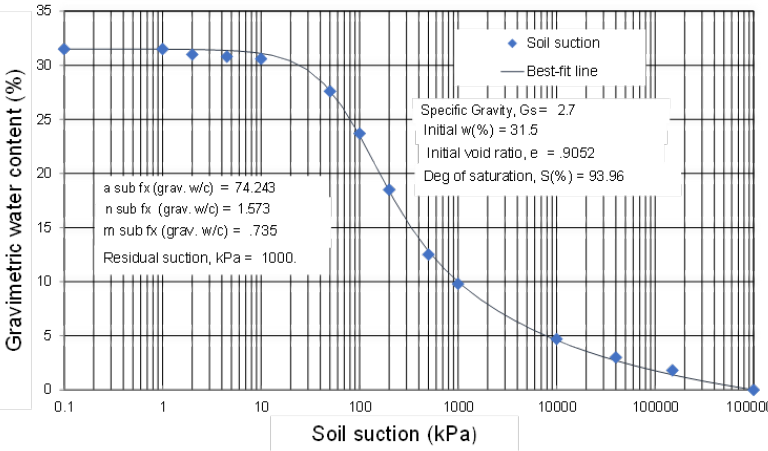
Figure 11. Regression analysis of the laboratory data, and graphical presentation of the regression analysis for the w -SWCC.